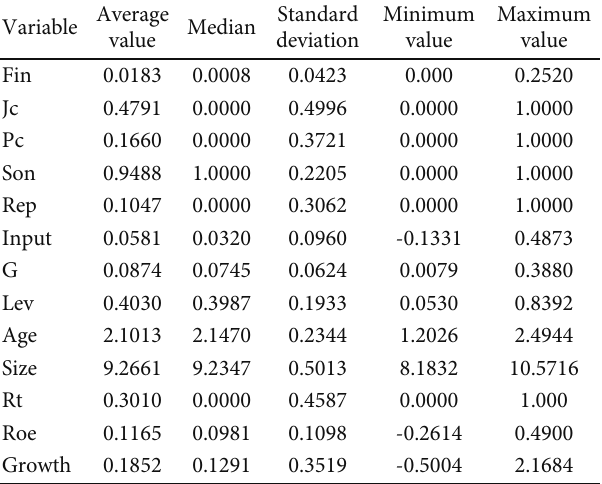
Table 2: Descriptive statistics of related variables. Average Variable value